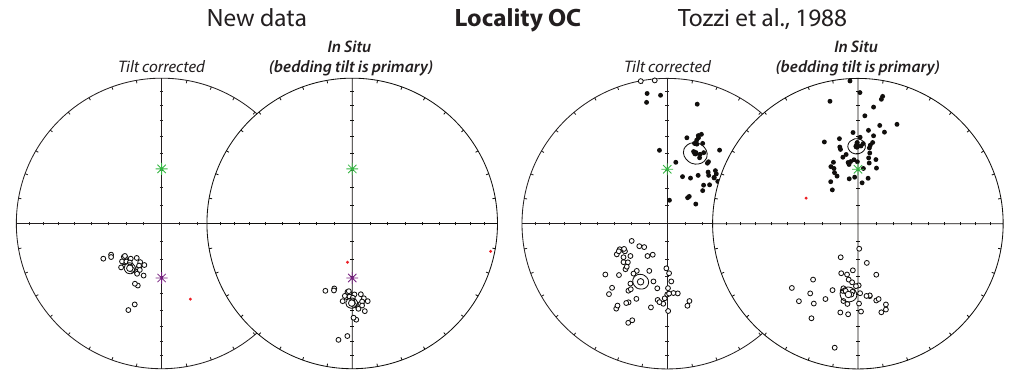
Figure 6 Figure 6. Equal area projections of both in situ and tilt-corrected ChRMs from our site OC (left) and from the same locality of Tozzi et al. (1988) (right), illustrating the apparent clockwise rotation that would result from a tilt correction of the bedding at this locality. The strata here have a primary dip (Fig. 7) and should be considered in in situ coordinates. Symbols are as in Fig.